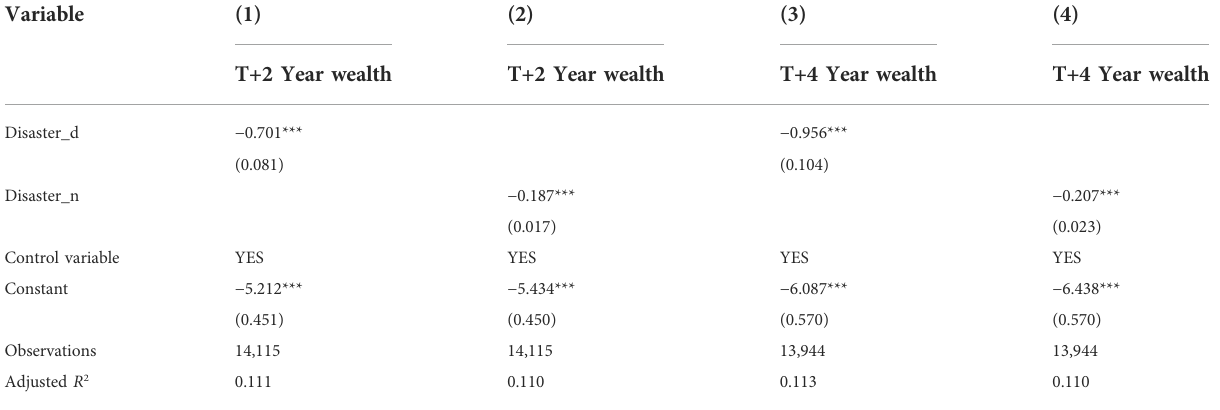
TABLE 11 Medium- and long-term effects of natural disasters on household